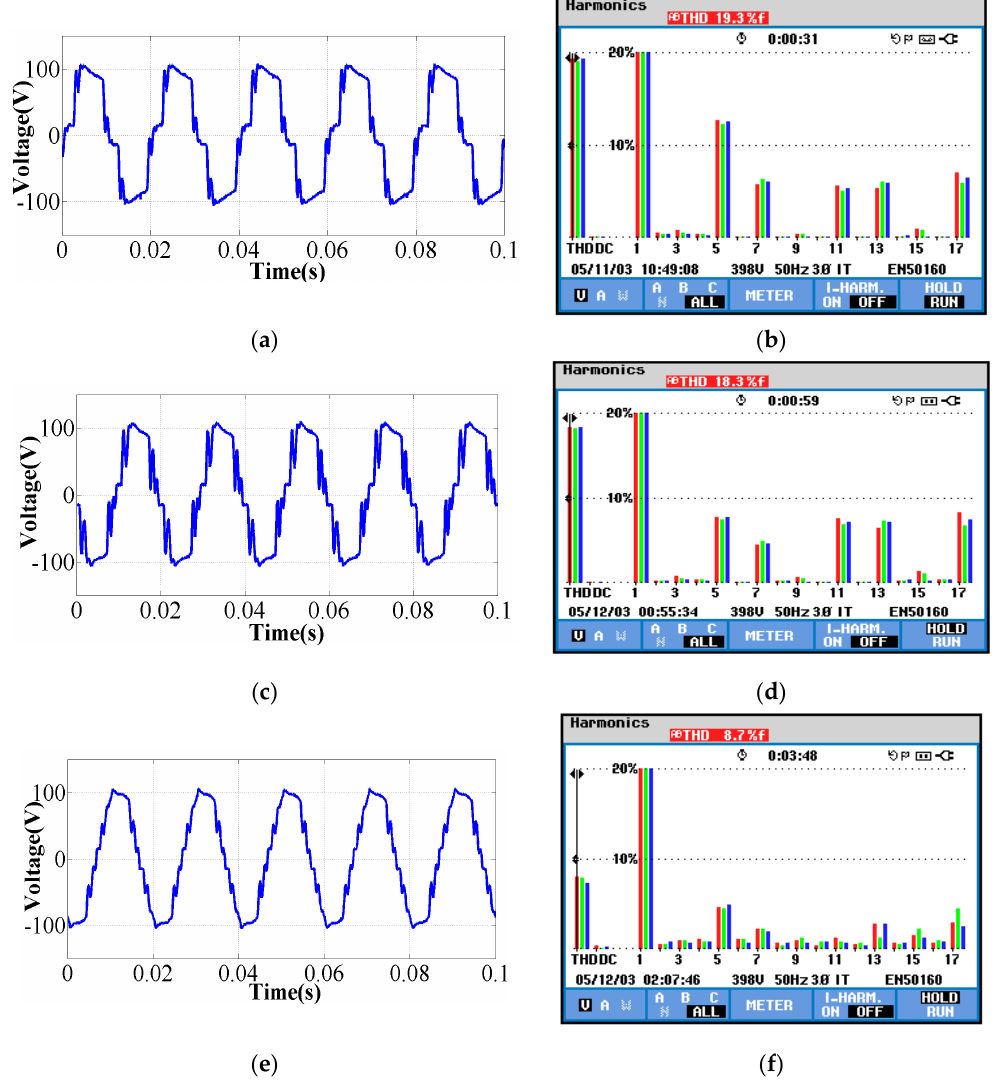
Figure 11. The experimental results of the output voltage. ( a ) The output voltage waveform without compensation; ( b ) The voltage FFT without compensation; ( c ) The output voltage waveform with the conventional compensation algorithm; ( d ) The voltage FFT with the conventional compensation algorithm; ( e ) The output voltage waveform with the proposed compensation algorithm; ( f ) The voltage FFT with the proposed compensation algorithm.